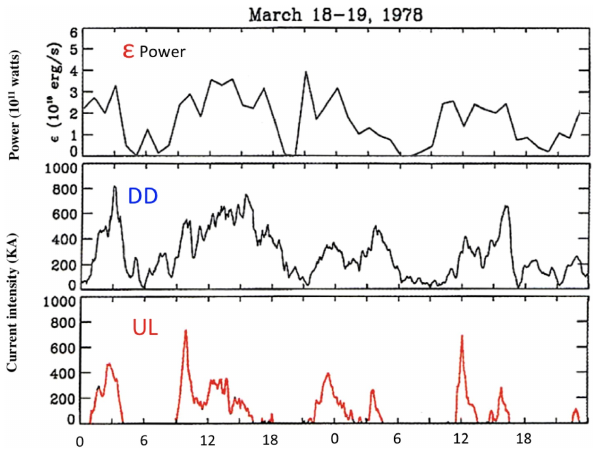
Figure 6. Time variations in the power ε , the DD current, and the UL current (Sun et al., 1998). Note that the DD tends to follow ε but the UL is impulsive (Akasofu, 2013).